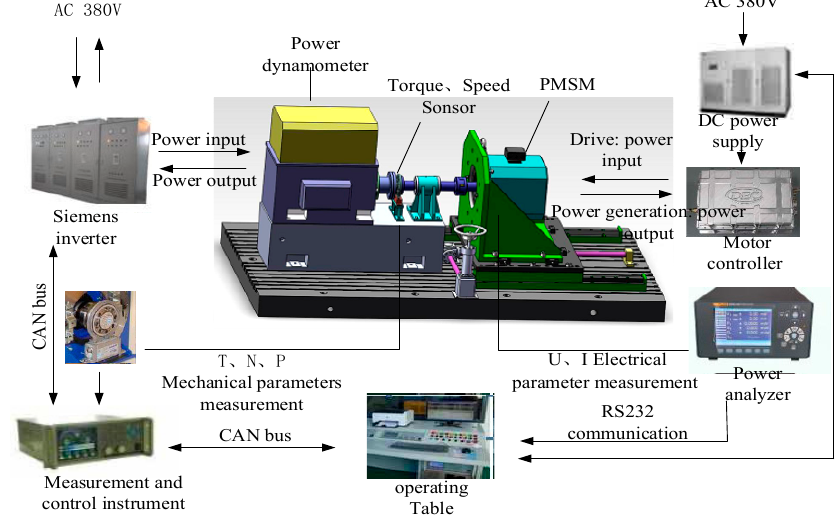
Figure 10. Experimental bench of PWIWM.